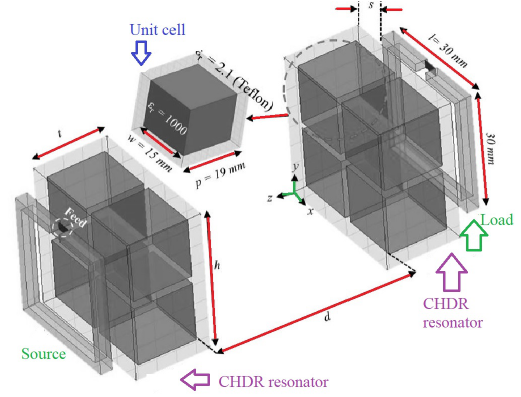
Figure 3. A WPT system with cubic high-dielectric